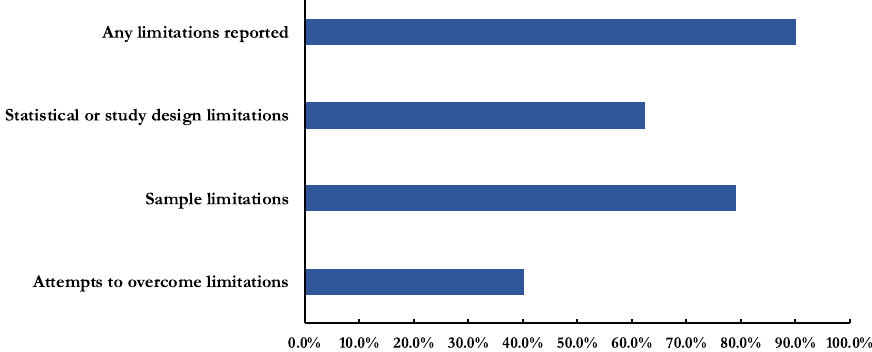
FIG. 3. Percentage of manuscripts that had reported on limitations.